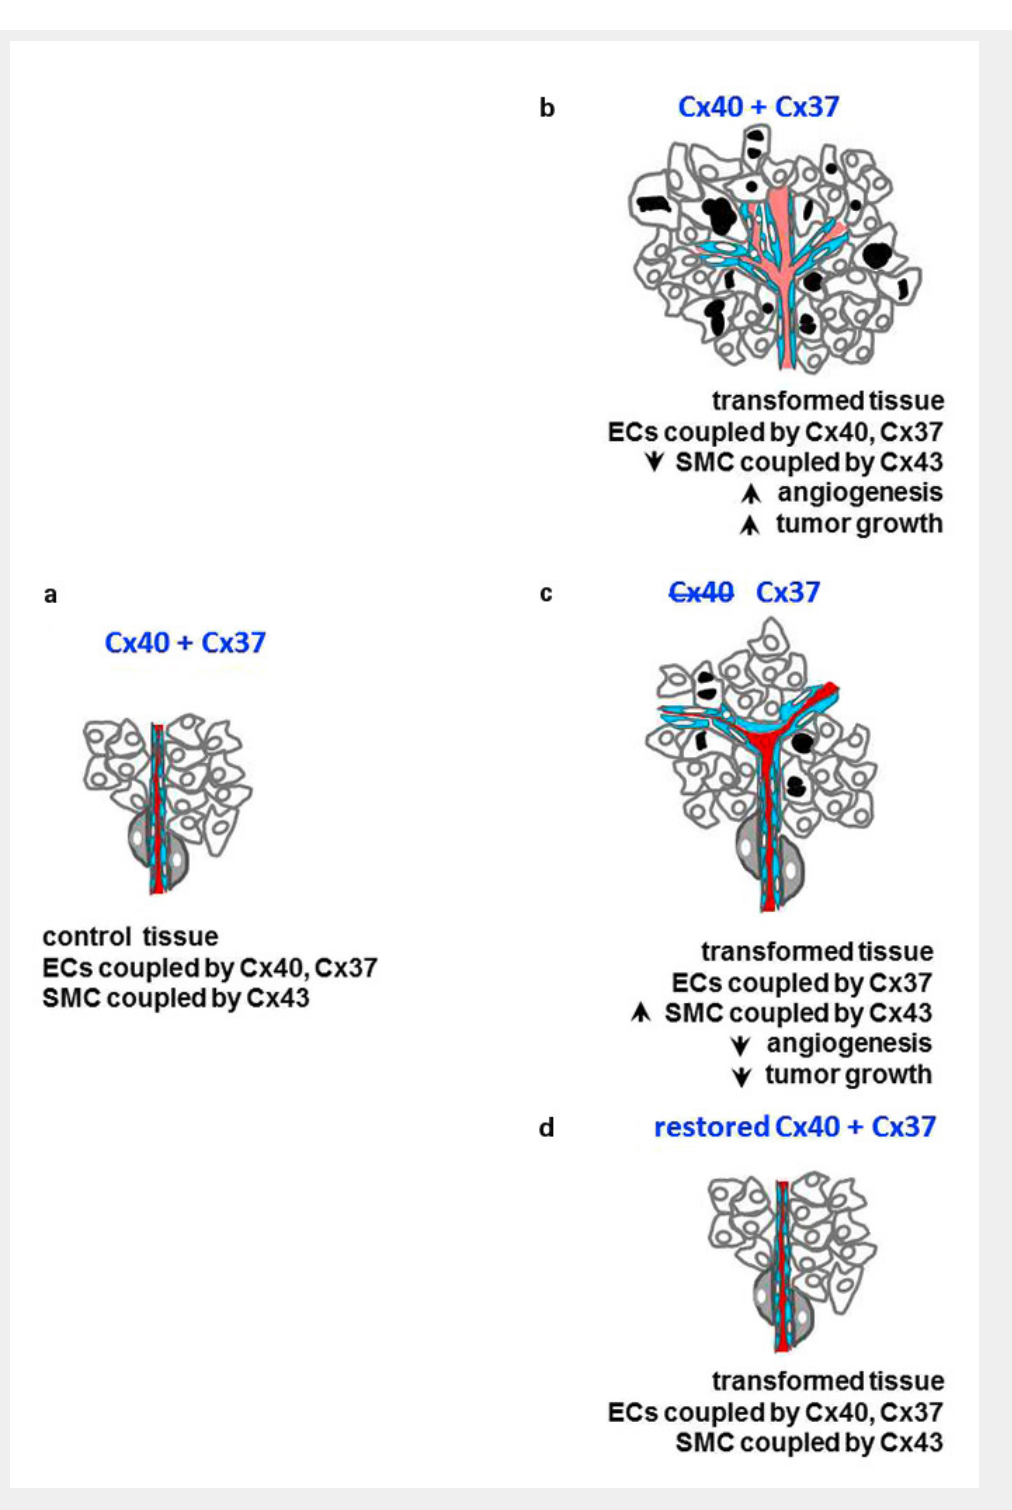
Figure 4 Cx40, cancer growth and angiogenesis. (a) In most tissues, the endothelial cells of micro vessels are coupled (blue) by Cx37 and Cx40 channels. (b ) The tumoral growth of transformed tissues is usually associated with the proliferation of endothelial cells, resulting in the excessive development of new vessels, which feature abnormal walls lacking pericyte (grey cells) coverage. (c ) These alterations, and the growth of transformed cells are decreased after loss of Cx40, resulting in a prolonged survival of the tumour-bearing animals. (d ) Restoration of Cx40 expression in endothelial cells, prevents both excessive angiogenesis and tumour